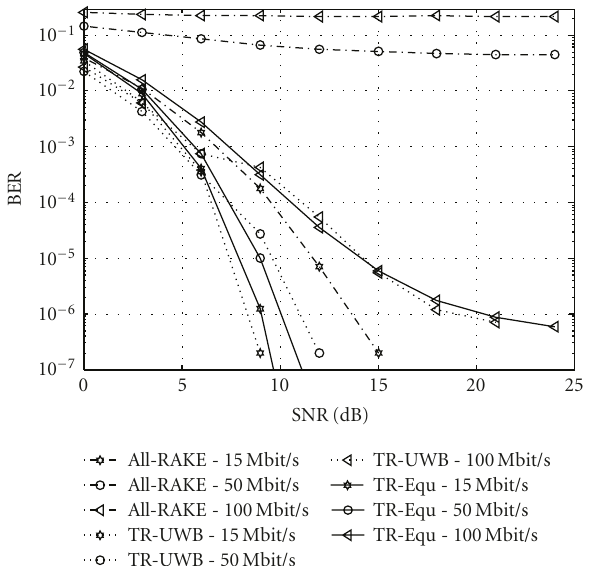
Figure 8: BER curves for ISI with Reed-Solomon coding ( N s = 5).